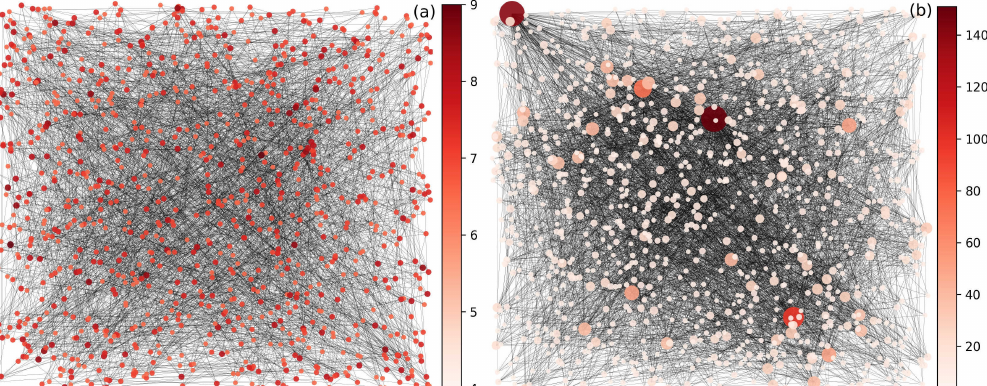
Figure 2. Representation of the networks used in this paper. Panel ( a ) depicts the small-world network with 1024 nodes and 4650 connections, and panel ( b ) the scale-free network with 1024 nodes and 4088 connections. The existence of hubs of connections is observed in the scale-free network, and the degree of connectivity decays in a power-law form, while in the small-world one the degree of connectivity is similar between